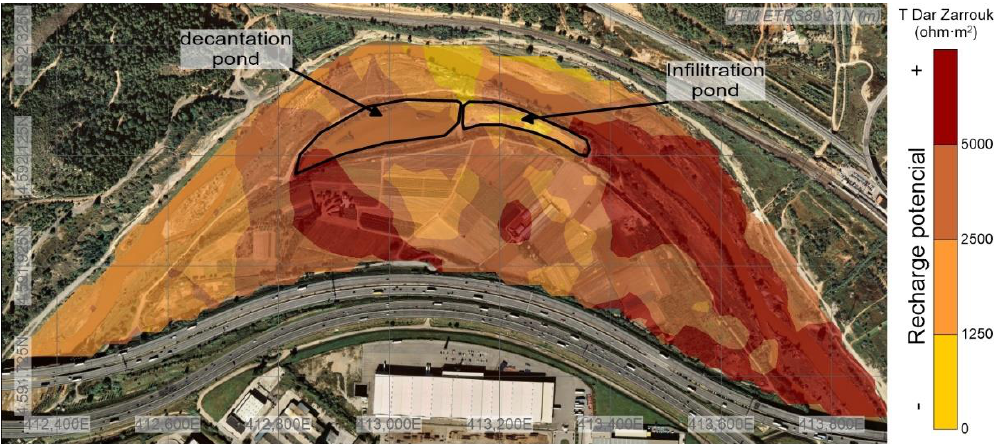
Figure 11. T Dar Zarrouk map showing the variability of hydraulic transmissivity of the aquifer (Ca n’Albareda meander).